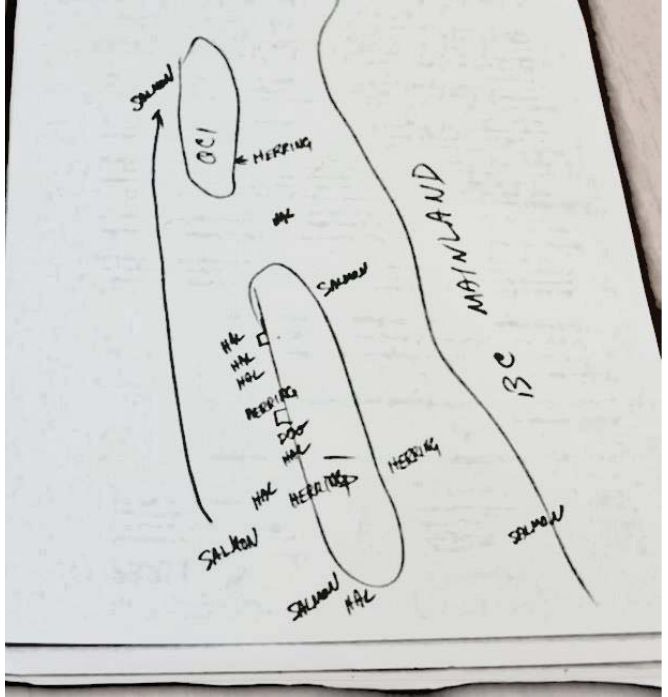
Figure A7 .1: Sample depiction of local ambit—non-First Nations